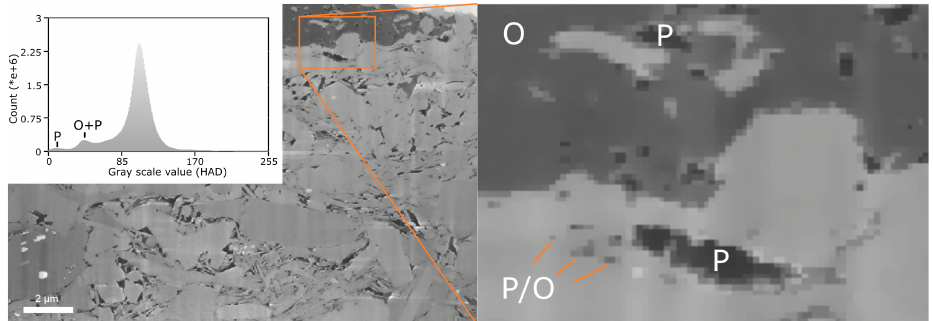
Figure 1. Image of filtered SE image on the left and enlarged orange box on the right. Black colors represent the pore space, dark gray organic matter and small pores. Both regions can be separated by thresholding gray scale values as shown by the histogram in the top left corner. On the right enlarged red box, the pore space is black (pixel size in this image is 40nm). In 2-D the pores are not connected but in 3-D some of the pores are connected, grouped into